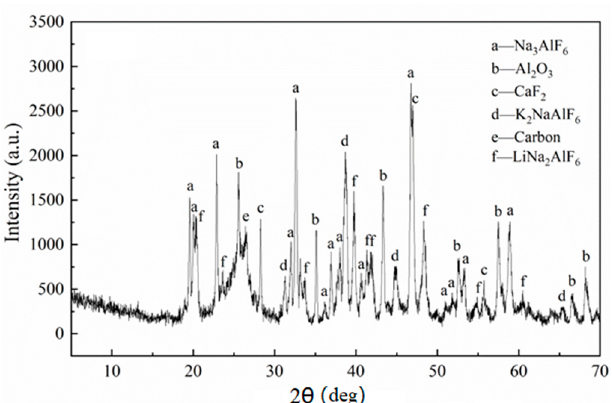
Figure 1. X-ray diffraction (XRD) pattern of electrolytic aluminum carbon dust. Table 1. Relative content of the main component of carbon dust. Composition.